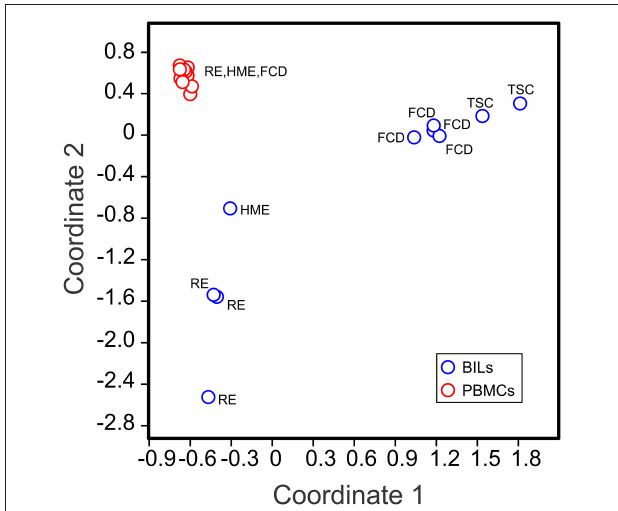
FIGURE 3 | Clustering of BILs and PBMCs from pediatric epilepsy surgeries. The relative number of cells in each cluster in each sample (as a percentage of the total number of CD45 + cells analyzed in each sample) was used to implement a principal component analysis (PCA). The first two components could account for 65.72% of the total variance in the data set. The 2D PCA plot shows that the BIL fractions are clearly different from the corresponding PBMCs, and that BILs from the RE and HME cases are distinct from those from the FCD and TSC